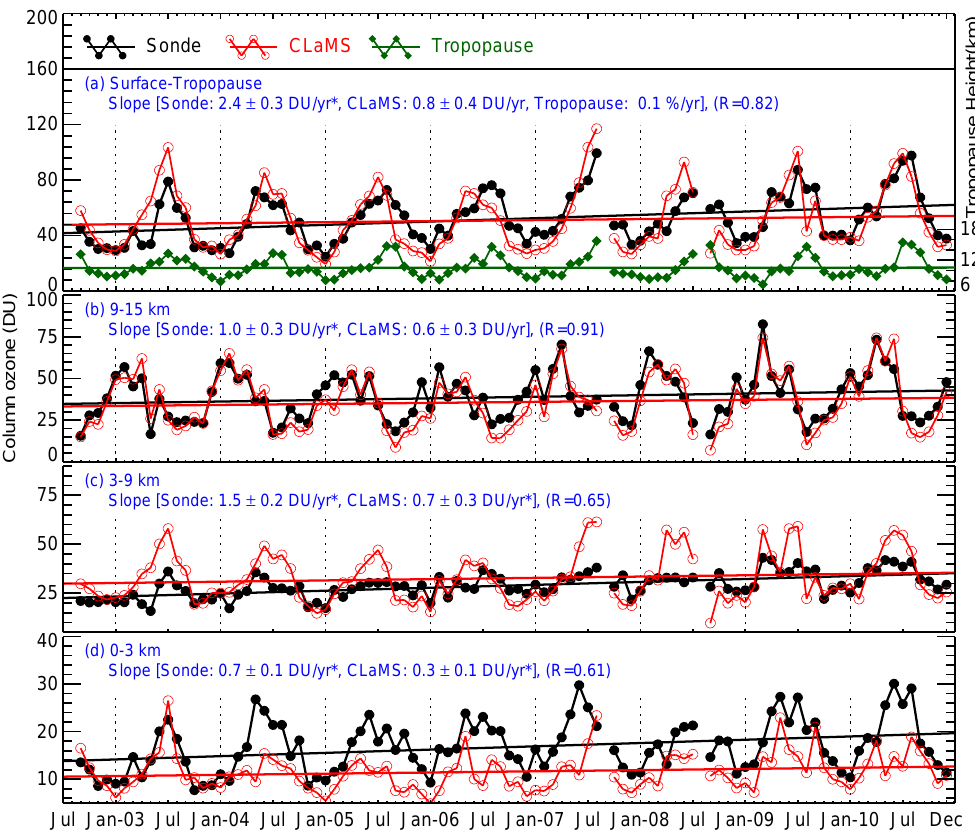
Fig. 3. Trends of monthly mean partial column ozone for (a) the whole troposphere (surface–tropopause), (b) 9–15km layer, (c) 3–9km layer and (d) 0–3km layer from observation (Sonde) and simulation (CLaMS) during 2002–2010, together with the first (LRT1) thermal tropopause. The numerical values for the slopes with symbol “*” pass the 95% significance criterion. The number R is the correlation coefficient between observation and simulation. There were no observations available during September 2007 and August